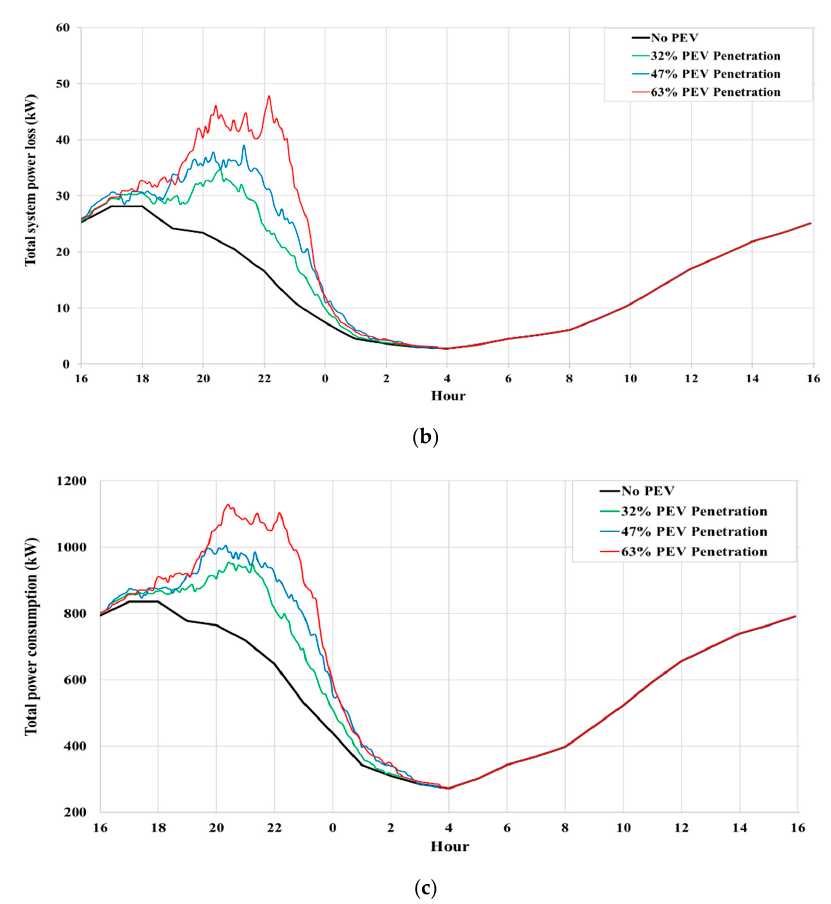
Figure 4. ( a ) Voltage deviation, ( b ) power loss, and ( c ) total power consumption during the uncoordinated PEV charging.